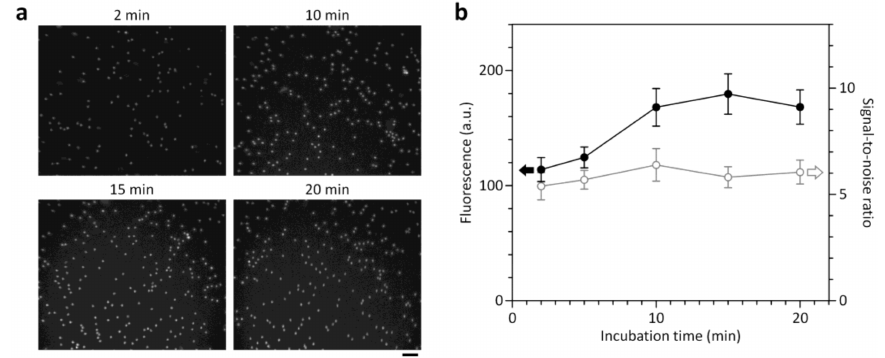
Figure 4. Kinetics of on-chip fluorescence cell staining. ( a ) Fluorescence images showing the time evolution of WBC staining in the counting chamber at a dye concentration of 750 µ M. Scale bar, 50 µ m. ( b ) Over time, the signal-to-noise ratio did not change significantly, while the fluorescence intensity of WBCs reached a plateau at 10 min. Error bars: s.d. ( n =